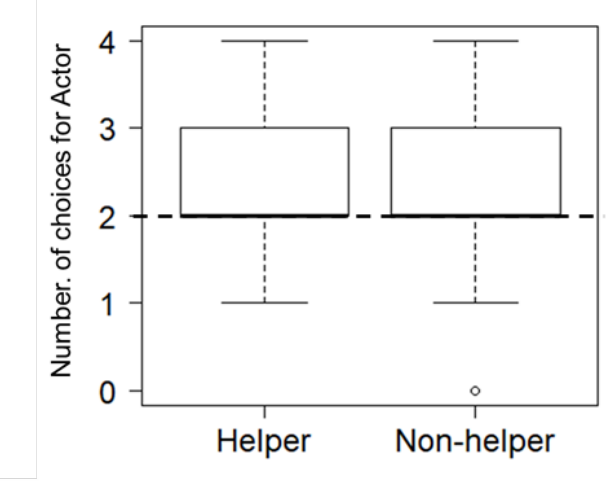
Note . Medians, first and third percentiles, ranges and outliers (dots) are shown. The dashed line shows chance level.